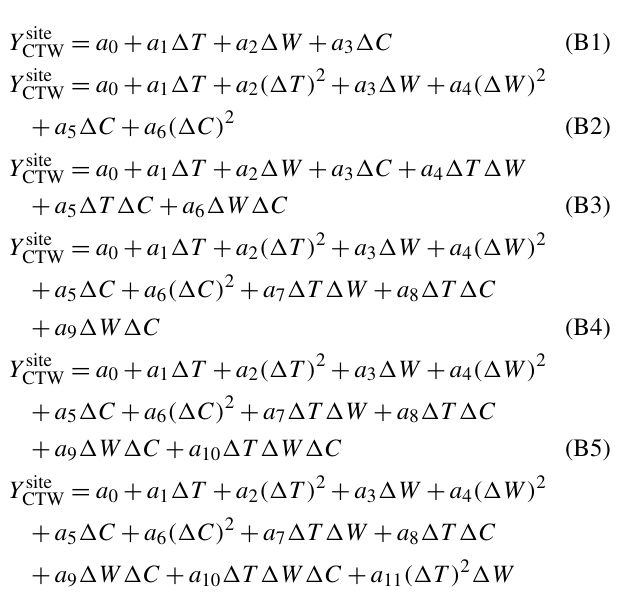
ror across the 99 tests for the site is the one used to provide a best estimate of baseline yield. This best estimate of baseline yield is used to convert the C3MP output yields at the site to percent changes in yield from baseline for emulator